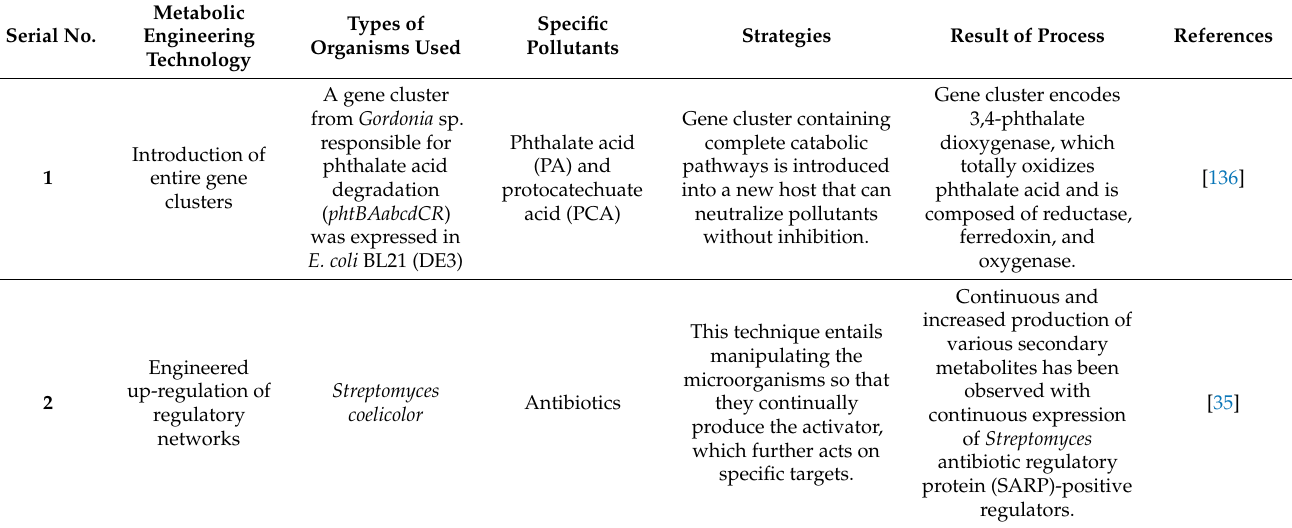
Figure 3. Illustration of sample collection from various environments and direct microbiome analysis using next-generation sequencing techniques (without the use of culture-dependent approaches). Different meta-omics approaches (metaproteomic, meta-transcriptomic, and metabolomic) were utilized to identify and detect microbial abundance and their metabolic functions in contaminated environments utilising next-generation sequencing platforms. Table 2. Metagenomic engineering approaches using bacterial host cells and their